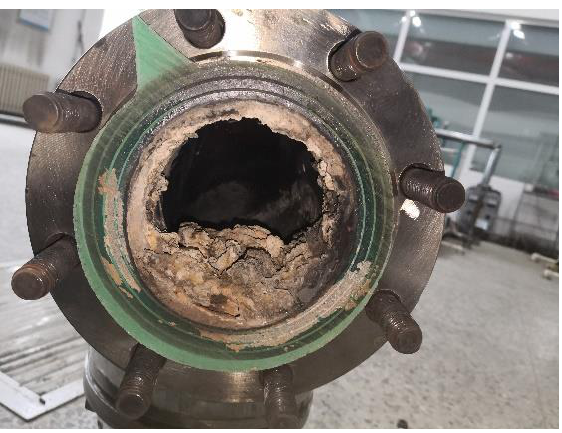
Figure 8. Precipitation and crystallization caused by urea injection in marine SCR system.